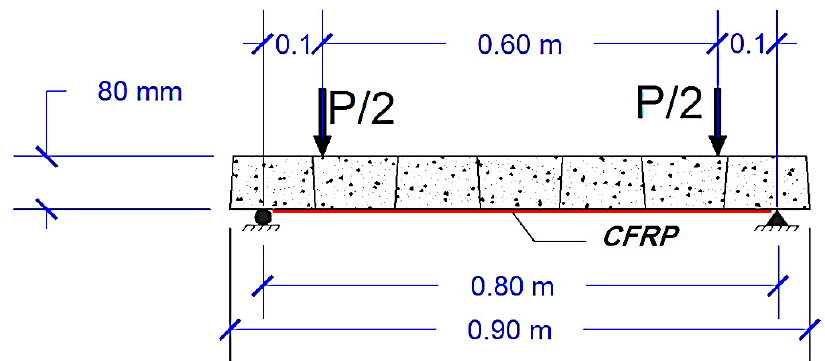
Figure 6. The schematic diagram for the segmental beam subjected to loading. Fibers 2020 , 8 , x FOR PEER REVIEW